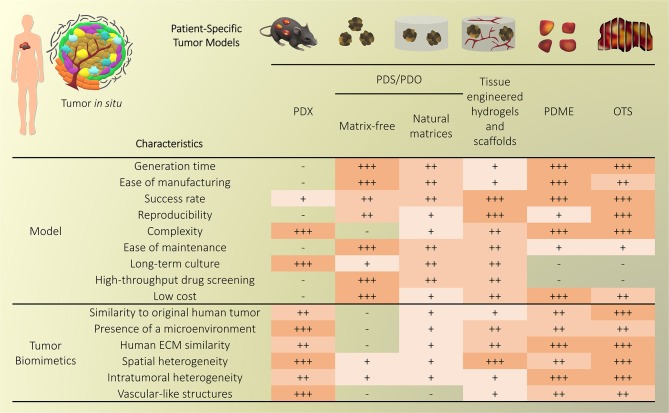
Advantages and disadvantages of current patient-specific tumor models.